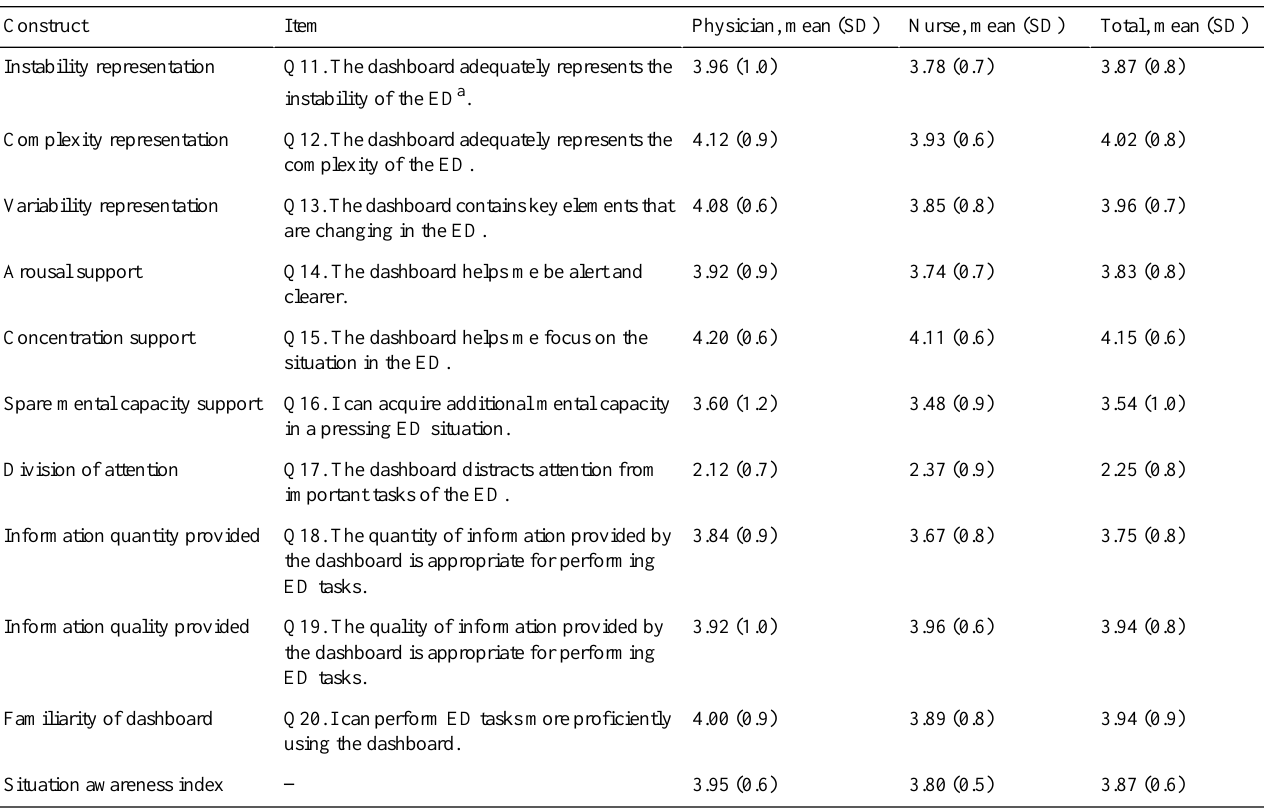
Table 3. Situation awareness and dashboard